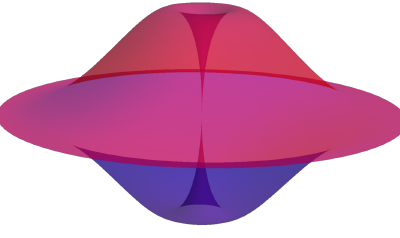
Figure 11 . The t = 0 surface of the stringy conical deficit geometry with M = 2 . This geometry is obtained from the disc { z ∈ C | | z | ≤ 1 } by the identification z ∼ − z on the